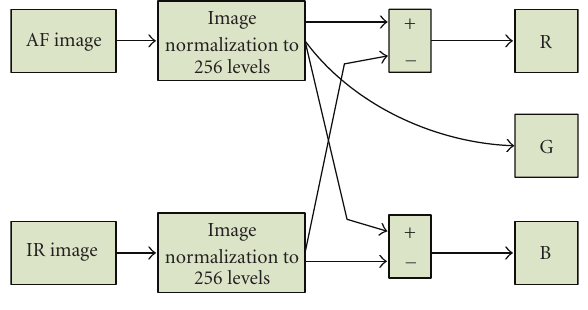
Figure 8: AF-IR fusion